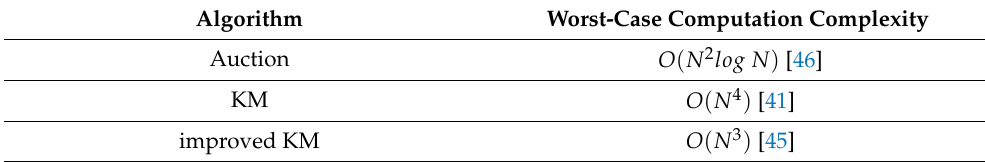
Table 3. Comparison of computation